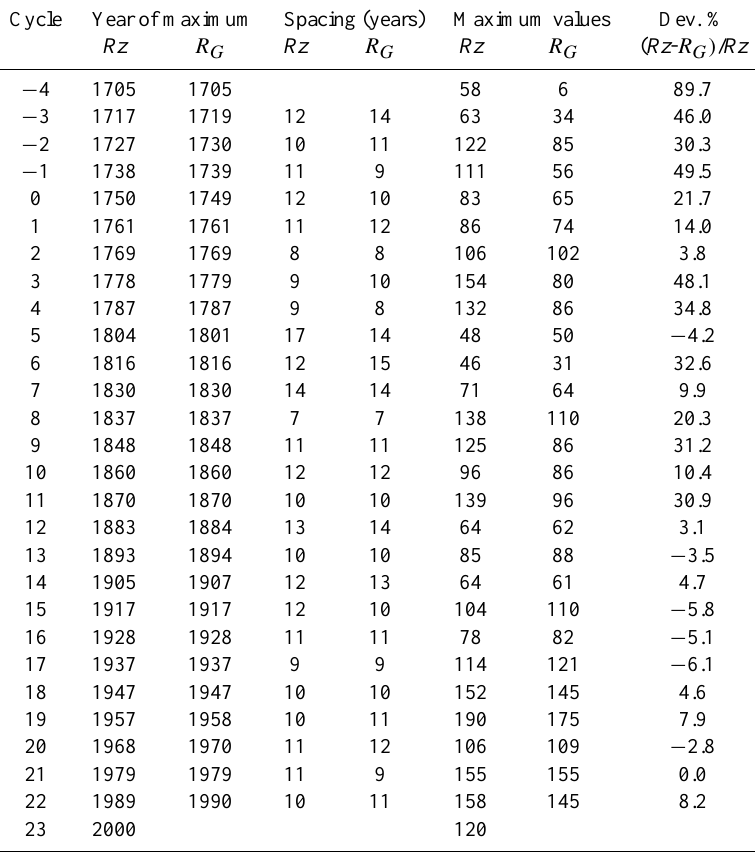
Table 1. Maximum yearly values of Rz and R G for cycles − 4 to 23, their years of occurrence, and the deviation (%) of R G values from the Rz values (last